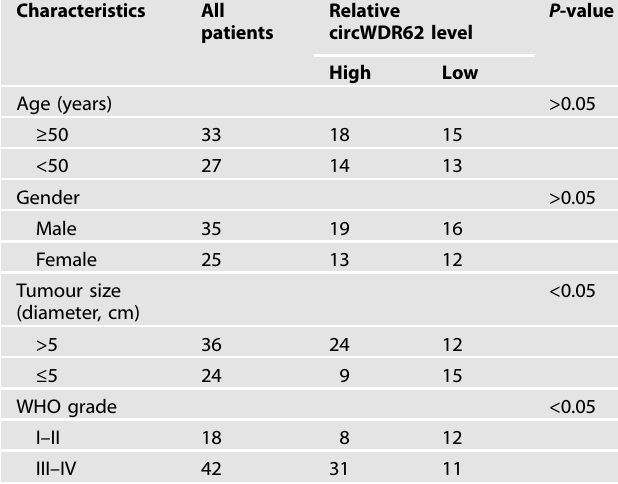
Table 1. The relationships between circWDR62 expression and the clinicopathological characteristics of glioma